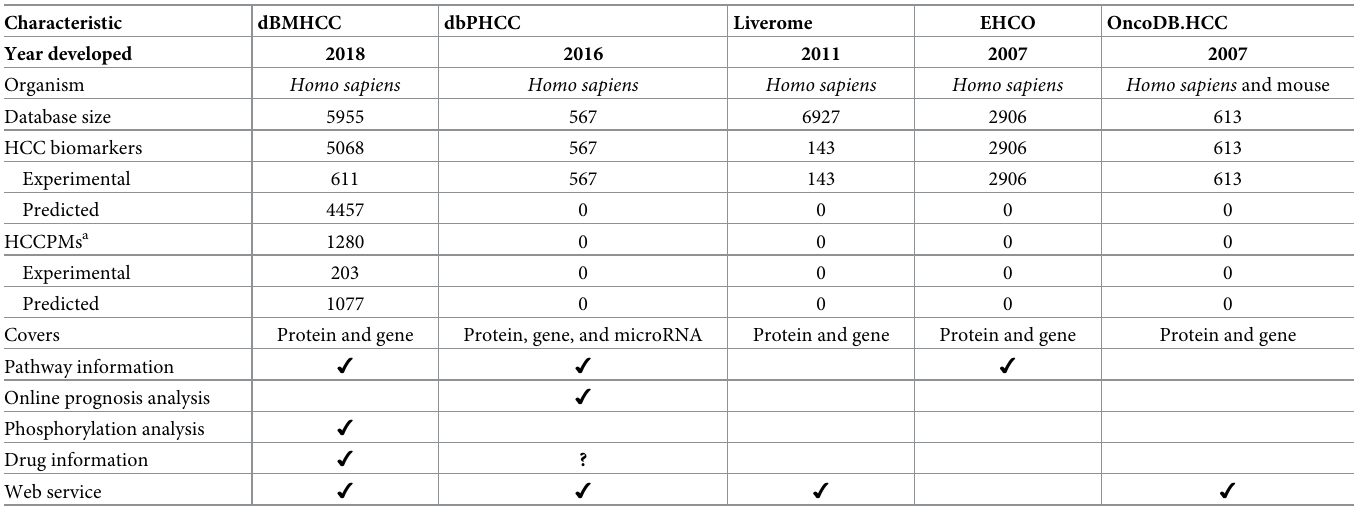
Table 1. Comparison of dBMHCC and other HCC-related